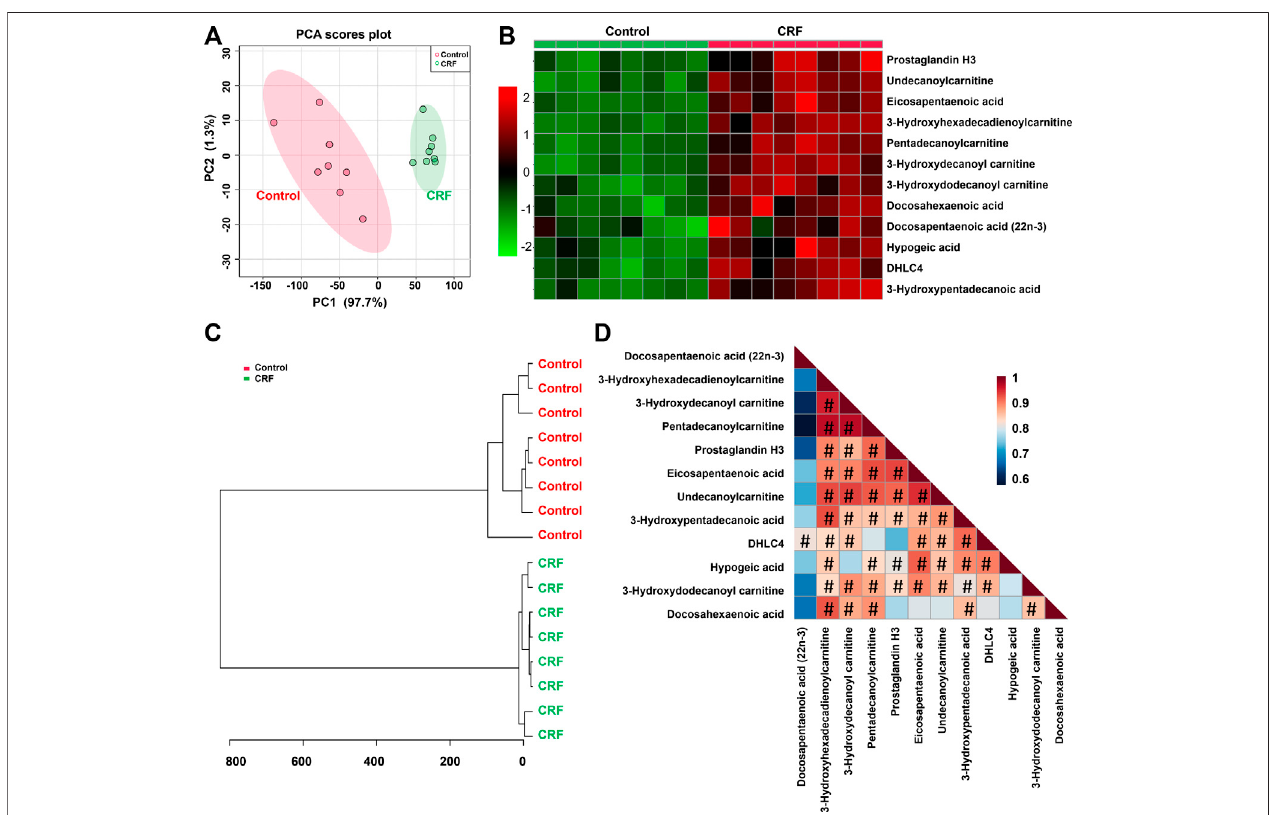
FIGURE 3 | CCr-associated with 12 lipid species were associated with impaired renal function. (A) PCA of two components of 12 lipid species from control and adenine-induced CRF groups. (B) Heatmap of 12 lipid species between control and adenine-induced CRF groups. Red and green indicate increased and decreased levels, respectively. (C) Clustering analysis of 12 lipid species between control and adenine-induced CRF groups. (D) Correlation of 12 lipid species among control and adenine-induced CRF groups.